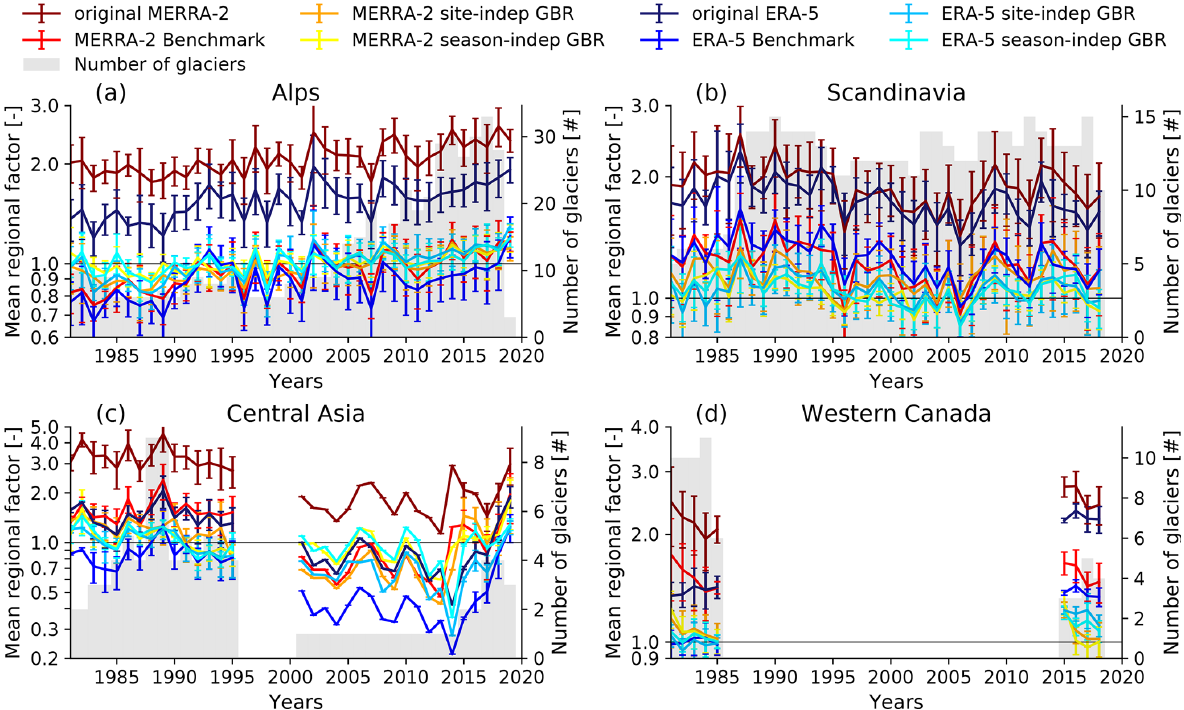
Figure 5. Mean regional factor between the B w data and the reanalysis-based models’ estimates as a function of the accumulation seasons from 1981 to 2019 (last available season): (a) the Alps, (b) Scandinavia, (c) Central Asia and (d) western Canada. The error bars indicate the standard deviation of the regional factors. For each season, all glaciers with available B w data were considered (the number of glaciers used to derive the regional factor is indicated by the grey